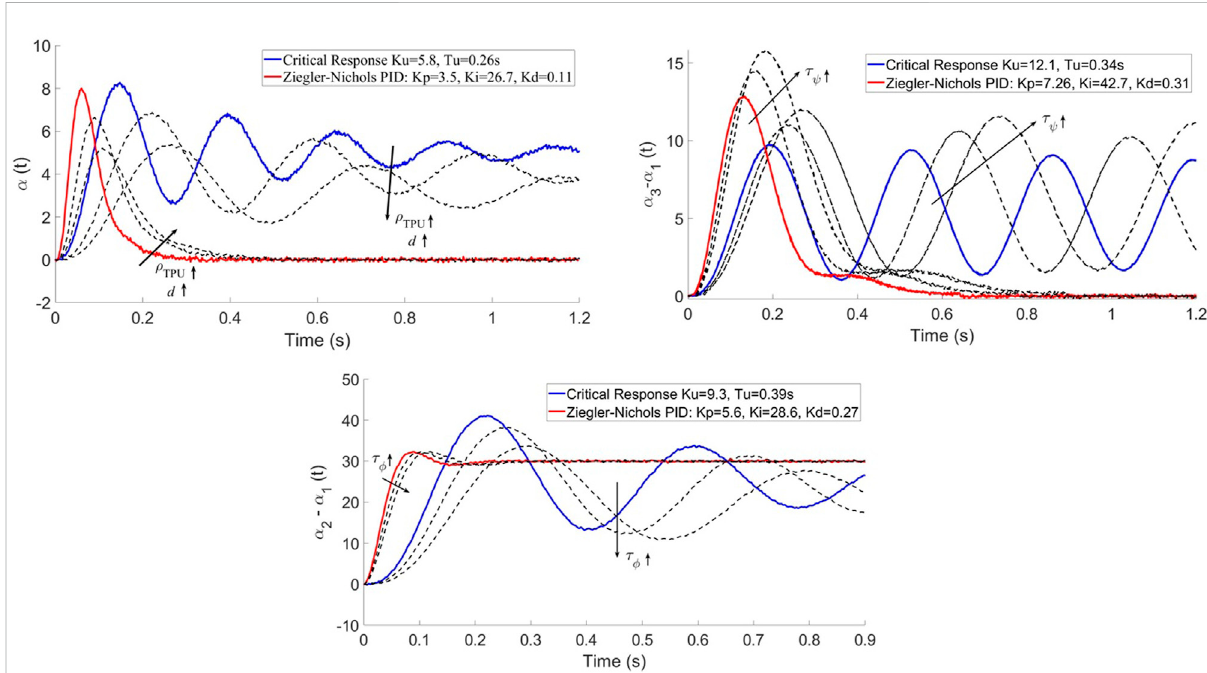
FIGURE 7 Disturbancerejectionofthecompensationsystemforhovering(topleft),yaw(topright);andstepresponseforpitchandroll(bottom).Theblue curveshowsthecriticalresponseofthesystemaccordingtoZiegler-Nichols( K u , T u ).Theredcurveshowstheresponseofthesystemfortheoptimal tuning of K p , K i , and K d according to Z-N method. The black dashed curves show the in fl uence of the system parameters ( ρ tpu , η aero , τ ϕ , τ ψ , τ θ ) on the